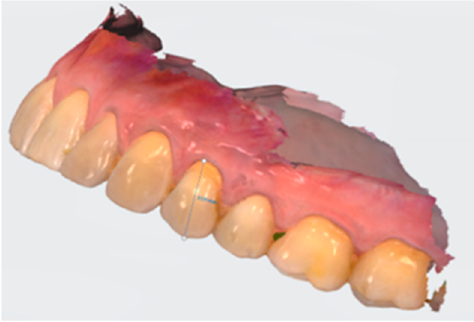
Figure 11. Digital measuring of the crown length on the digital intraoral scan.